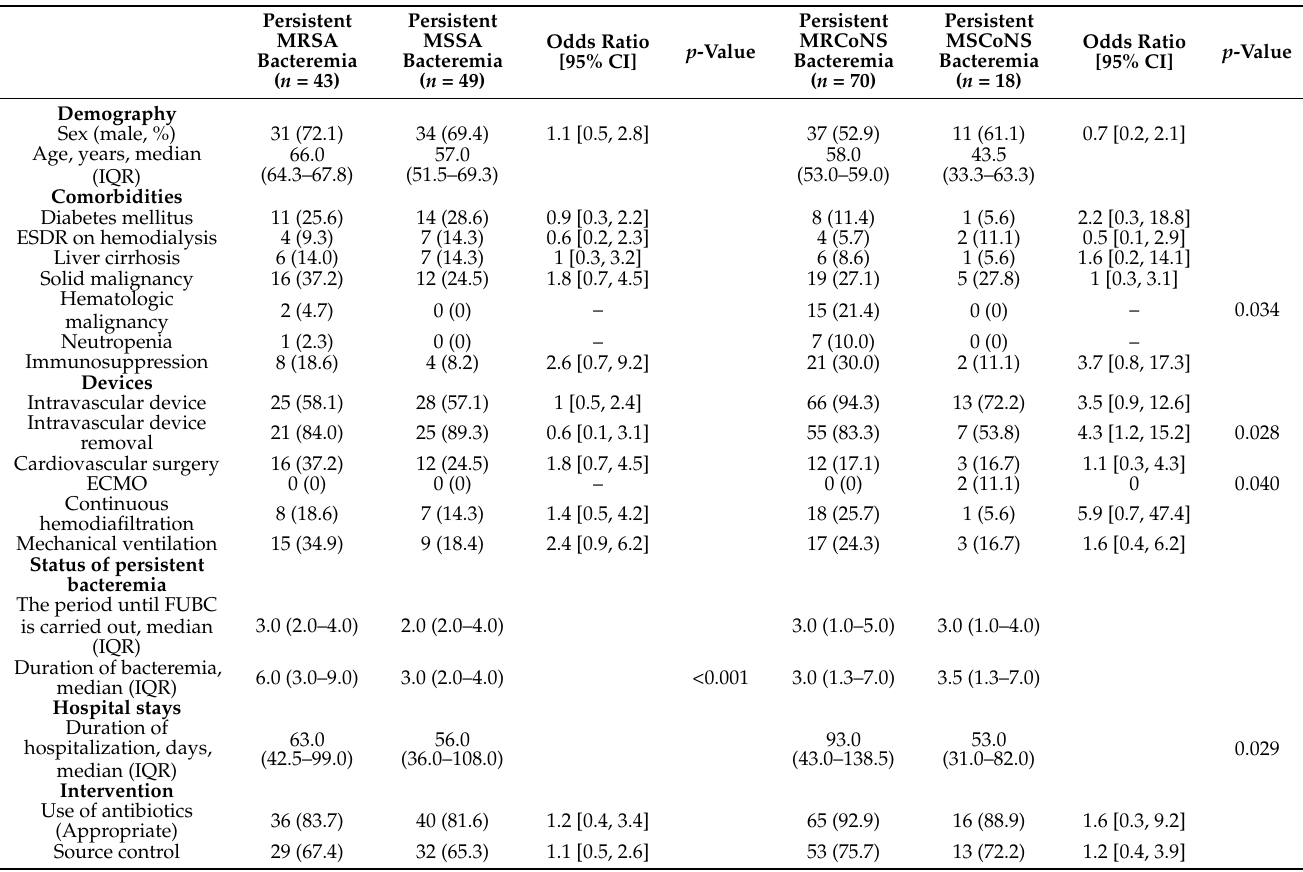
Table 2. Clinical characteristics of persistent Staphylococcus aureus bacteremia and persistent coagulase- negative Staphylococci bacteremia in terms of methicillin-resistant